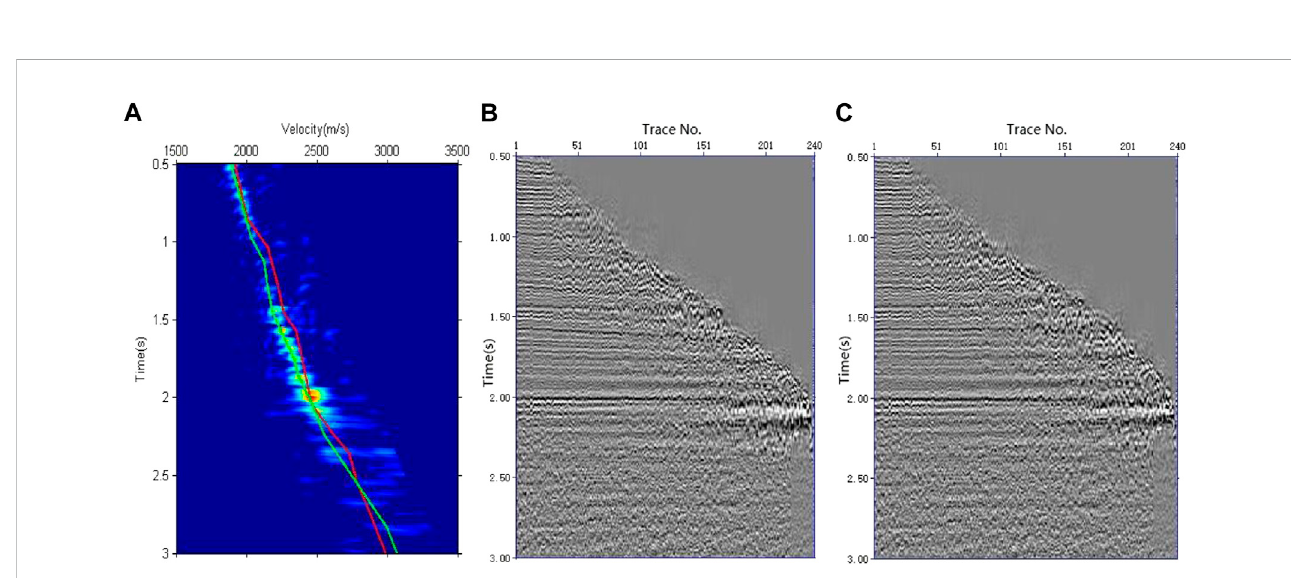
FIGURE 9 VelocitypickingandNMOcorrectionresults. (A) Velocitypickingresults,wheretheredlineistheconventionalk-meansclusteringmethodandthegreen is the weighted k-means clustering method. (B) NMO correction results while applying velocity picked by conventional k-means clustering. (C) NMO correction results while applying velocity picked by weighted k-means clustering.